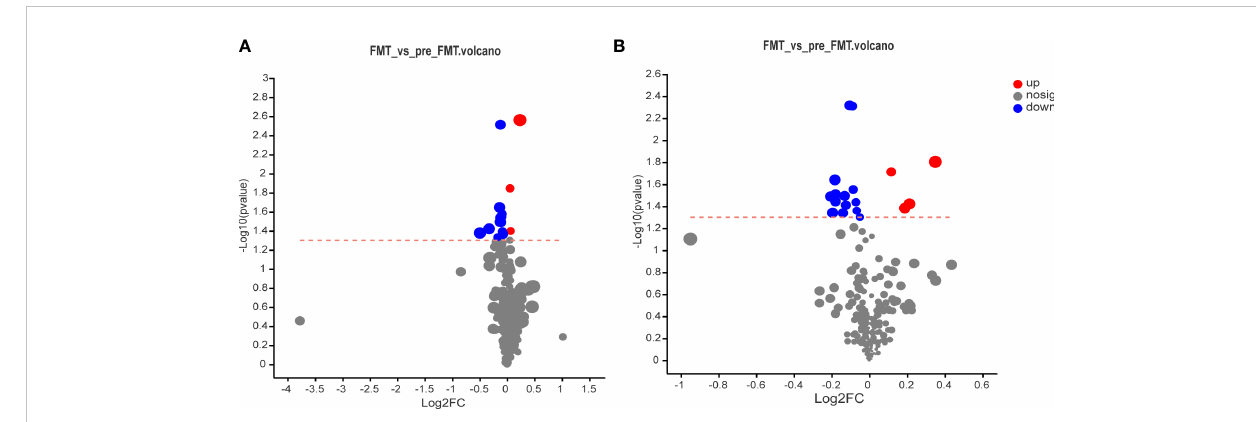
FIGURE 4 Volcano map of serum metabolomics before and after FMT. (A) Volcano map of cation surface. (B) Volcano diagram of anion table.